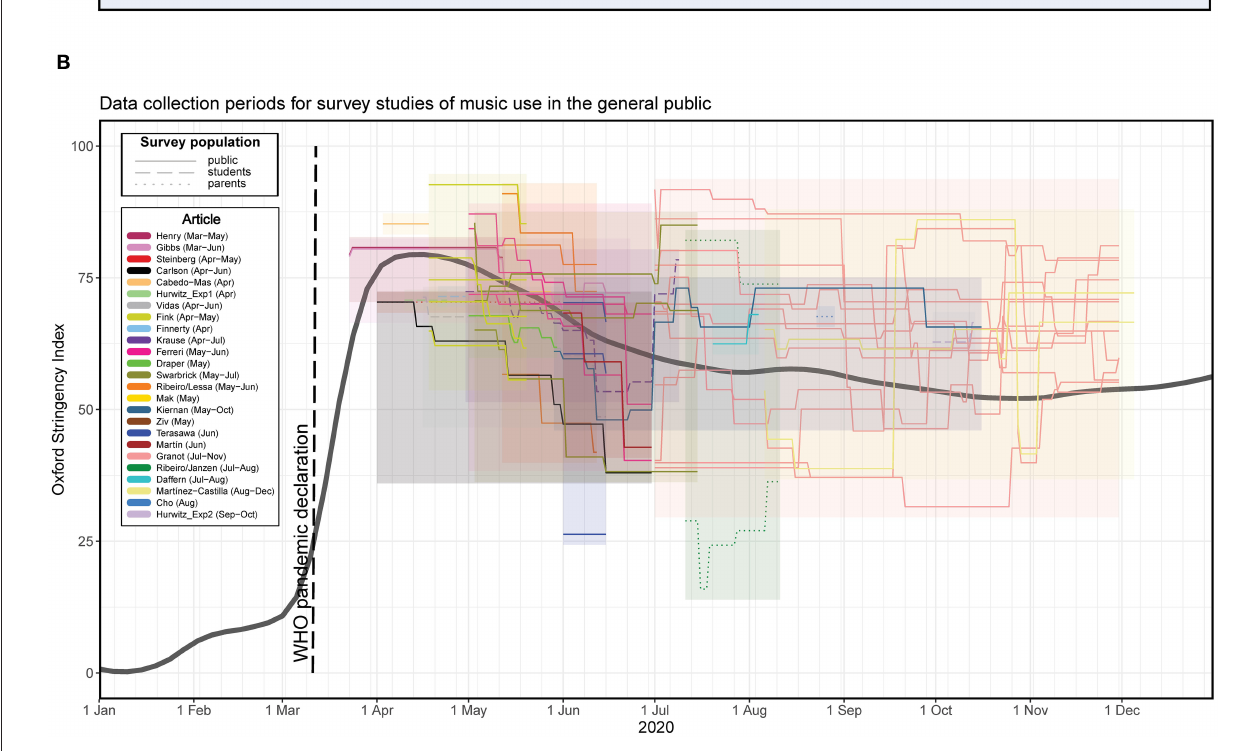
FIGURE 1 | (A) Overview of the methods applied to each of the overall topics within the current Research Topic. For articles pertaining to multiple topics and/or employing multiple methods, primary topics and methods are indicated in bold. (B) Timeline depicting Oxford Stringency Index (Hale et al., 2021) in surveyed countries during data collection times for questionnaire-based studies of music use in the general public conducted during the pandemic lockdowns of 2020.